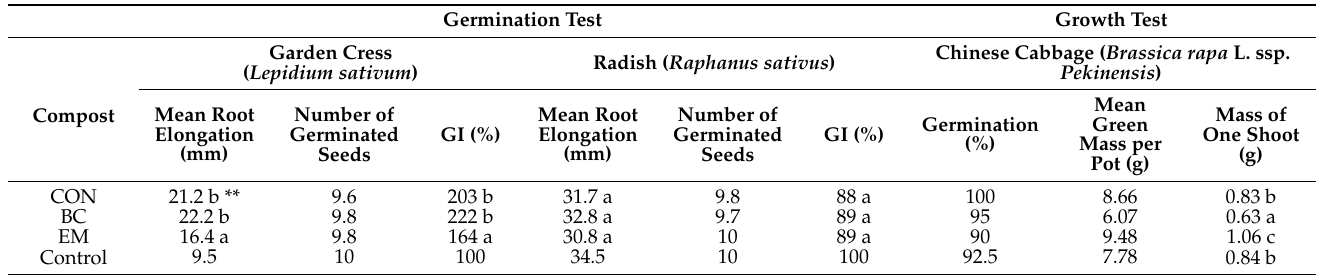
Table 5. Germination test with cress and radish seeds compared to average root length, number of germinated seeds and germination index (GI %) based on extracts of three different composts in comparison with control. On the right, Chinese cabbage growth test after 21 days of sowing seeds: germination performance, total shoot mass and mass of one shoot based on different